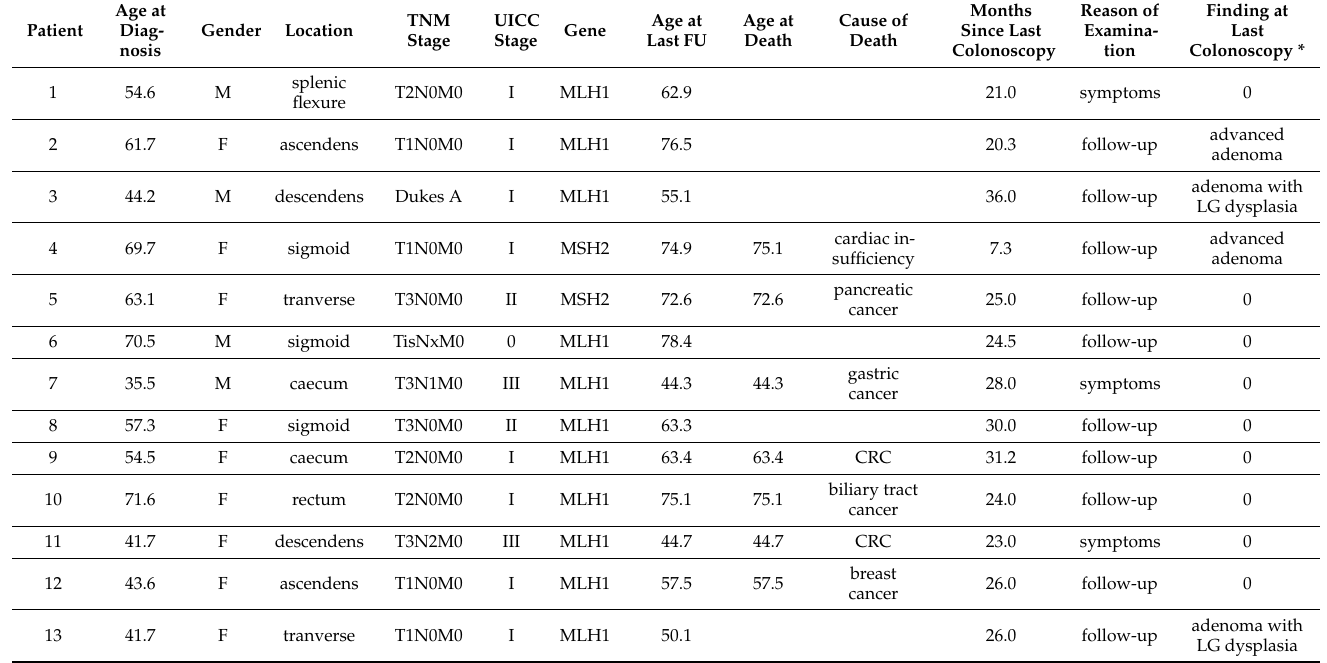
Table 1. Clinical characteristics of patients with incident